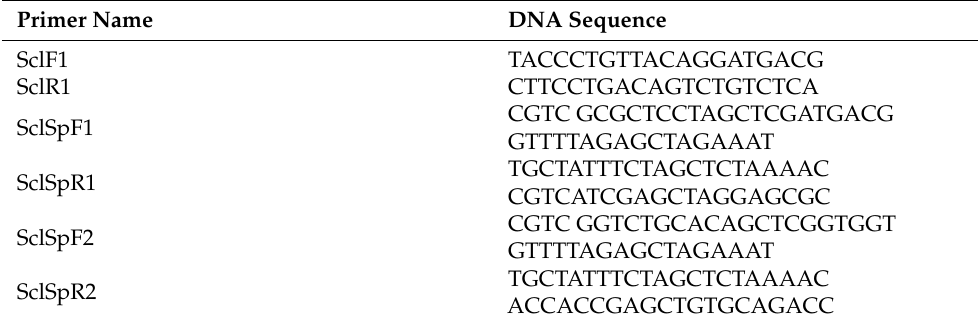
Table 1. Oligonucleotides used in this